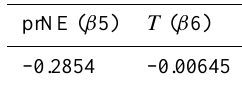
Table A3. Coefficients for the function (1).